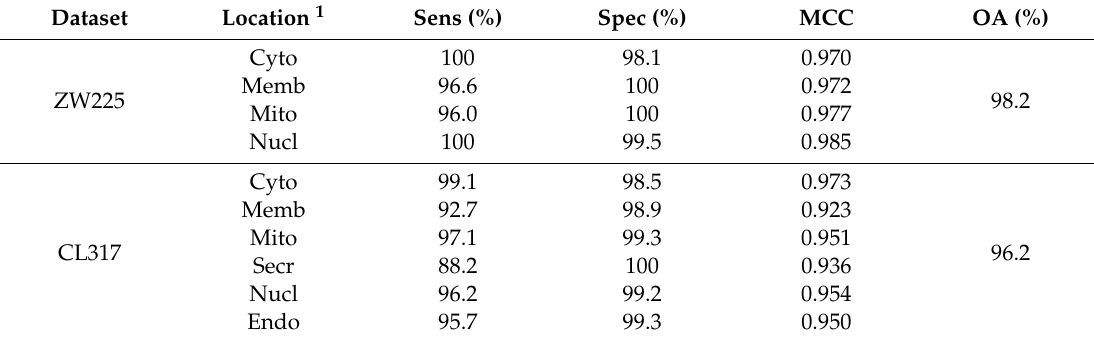
Figure 1. The graph illustrates the efficiency of various top features on the two datasets’ overall accuracies. Table 1. Results for the two datasets by jackknife Table 1. Results for the two datasets by jackknife tests.